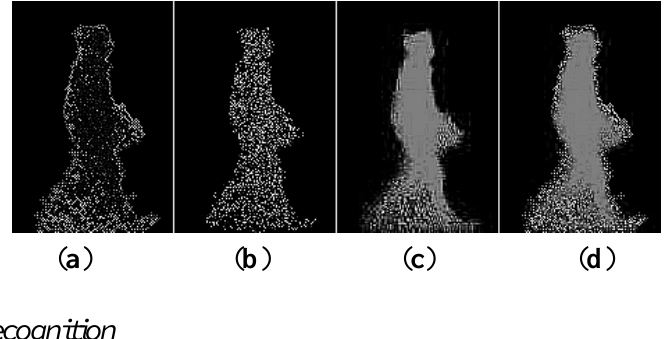
Figure 9. Curvature based 2D color gait feature image (CGCI): ( a ) R component; ( b ) G component; ( c ) B component; and ( d ) RGB